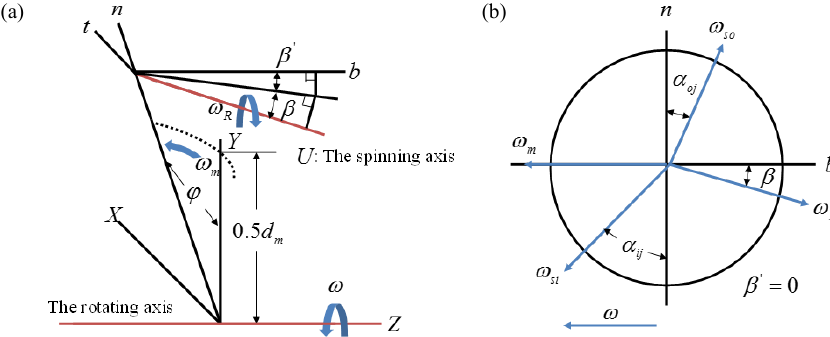
Figure 4. Velocities of ball bearing. (a) View of inner race. (b) View of rolling ball.